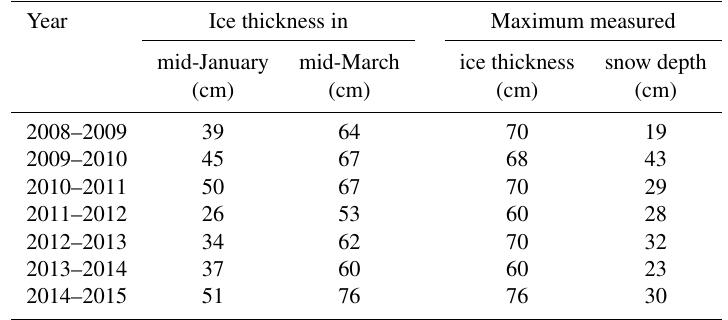
Table 2. Summary of the lake ice observations.